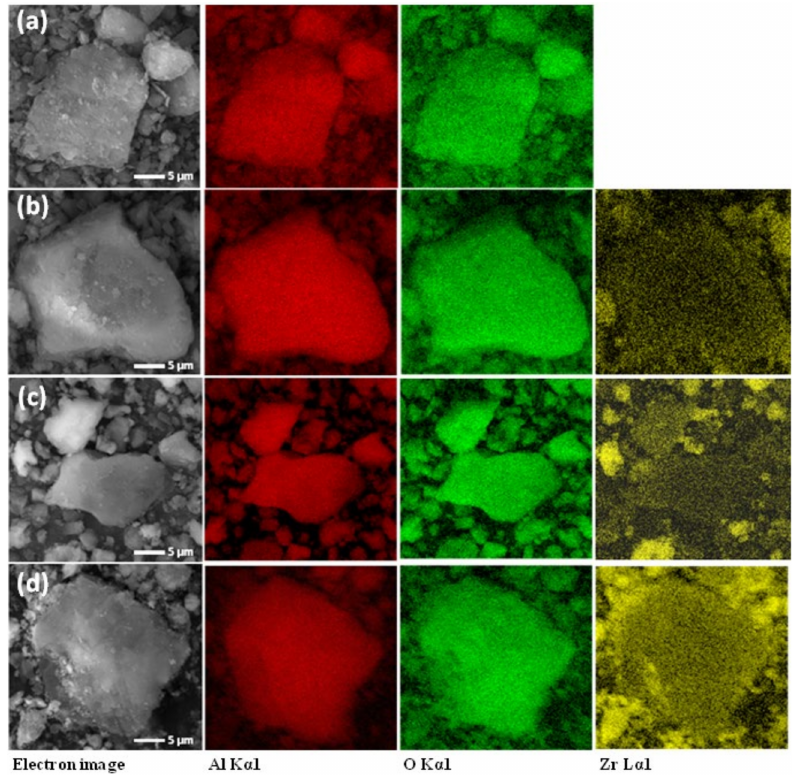
Figure 1. SEM-EDS mapping of ( a ) bare γ -Al 2 O 3 , ( b ) 9% Zr/ γ -Al 2 O 3 , ( c ) 16% Zr/ γ -Al 2 O 3 , ( d ) 35% Zr/ γ -Al 2 O 3